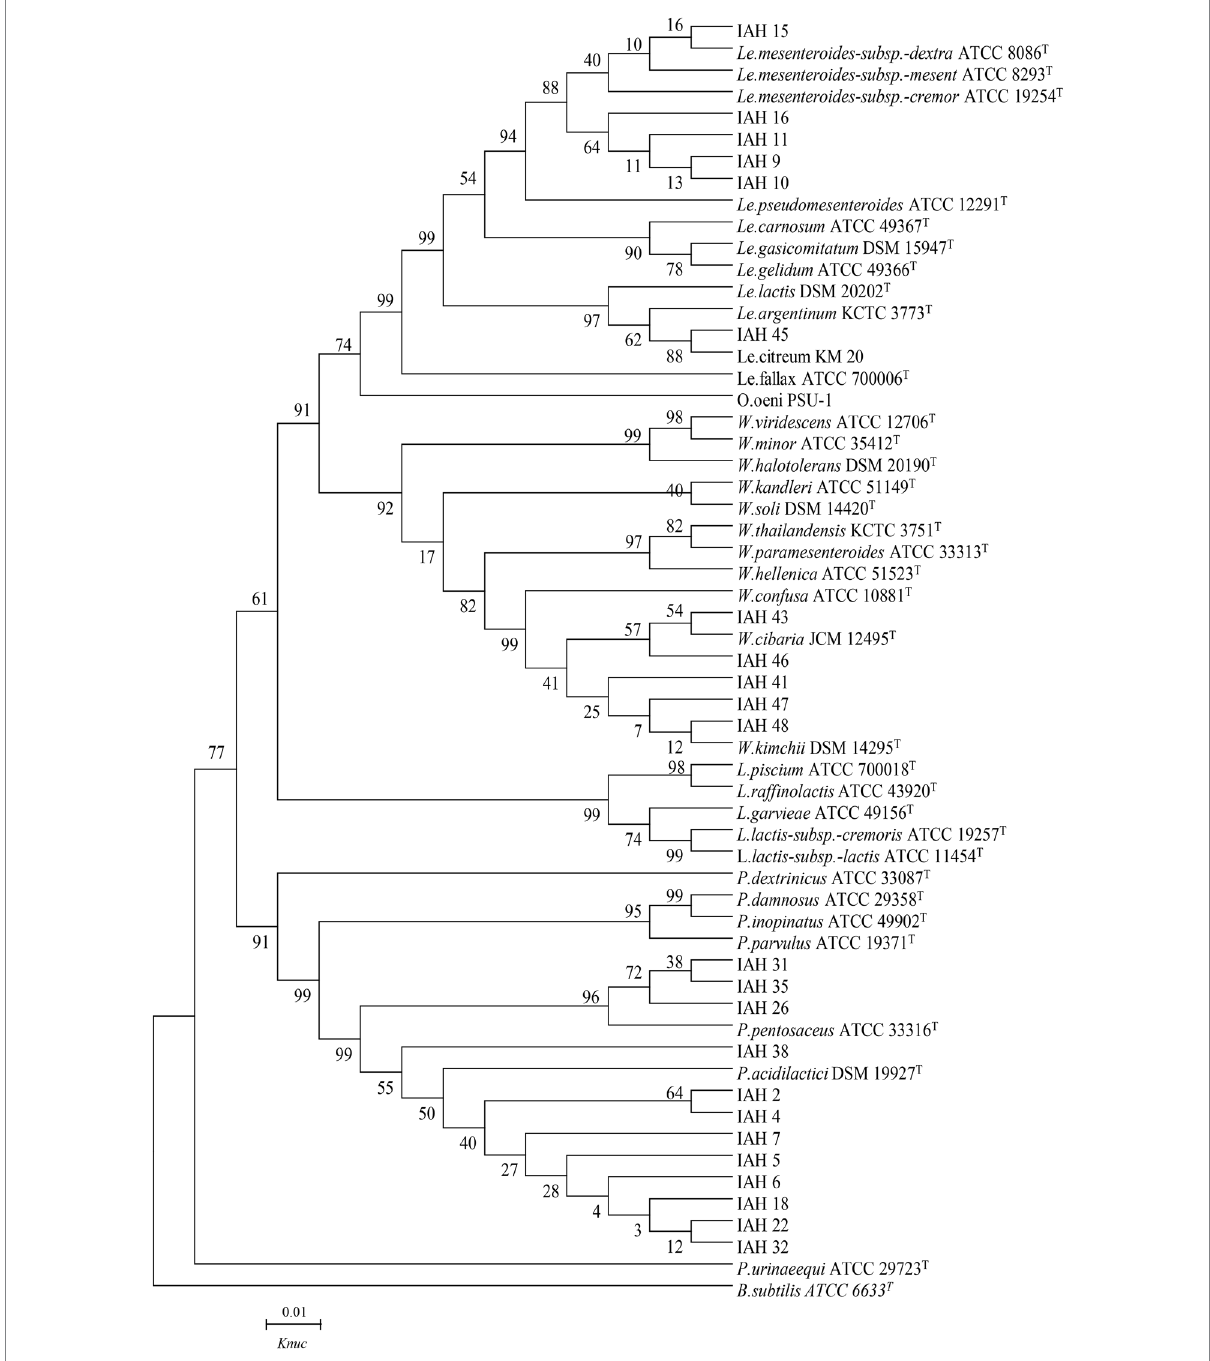
FIGURE 1 Phylogenetic tree showing the relative position of Leuconostoc , Weissella , Lactococcus , and Pediococcus species and representative strains isolated from natural grasses as inferred by the neighbor-joining method of complete 16S rDNA sequences with 1,000 replicates. Reference sequences of type strains from GenBank are used for comparison, Bacillus subtilis is used as the outgroup. The width is proportional to terminal branch lengths (1% sequence divergence, shown as a scale bar at lower right). Le. , Leuconostoc ; W. , Weissella ; L. , Lactococcus ; P. , Pediococcus . K nuc, nucleotide substitution